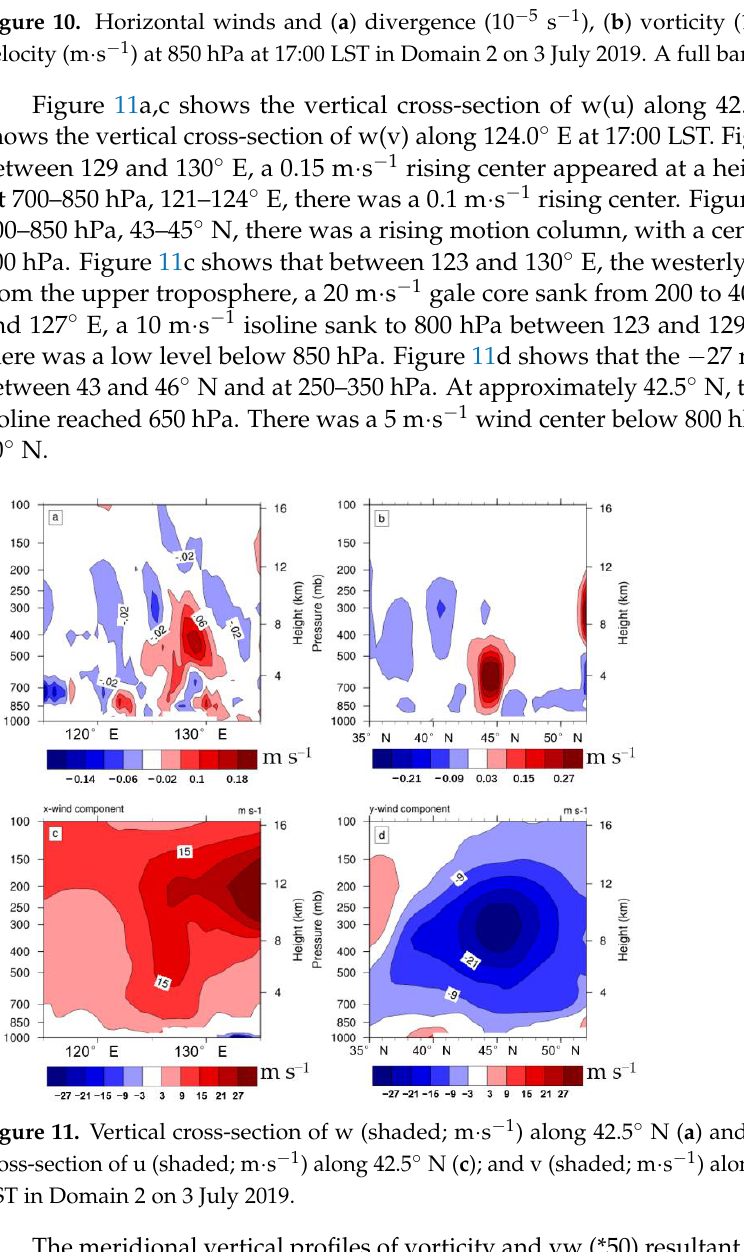
Figure 10. Horizontal winds and ( a ) divergence (10 − 5 s − 1 ), ( b ) vorticity (10 − 5 s − 1 ), ( c ) vertical velocity (m s −1 ) at 850 hPa at 17:00 LST in Domain 2 on 3 July 2019. A full bar is 4 m s − 1 .